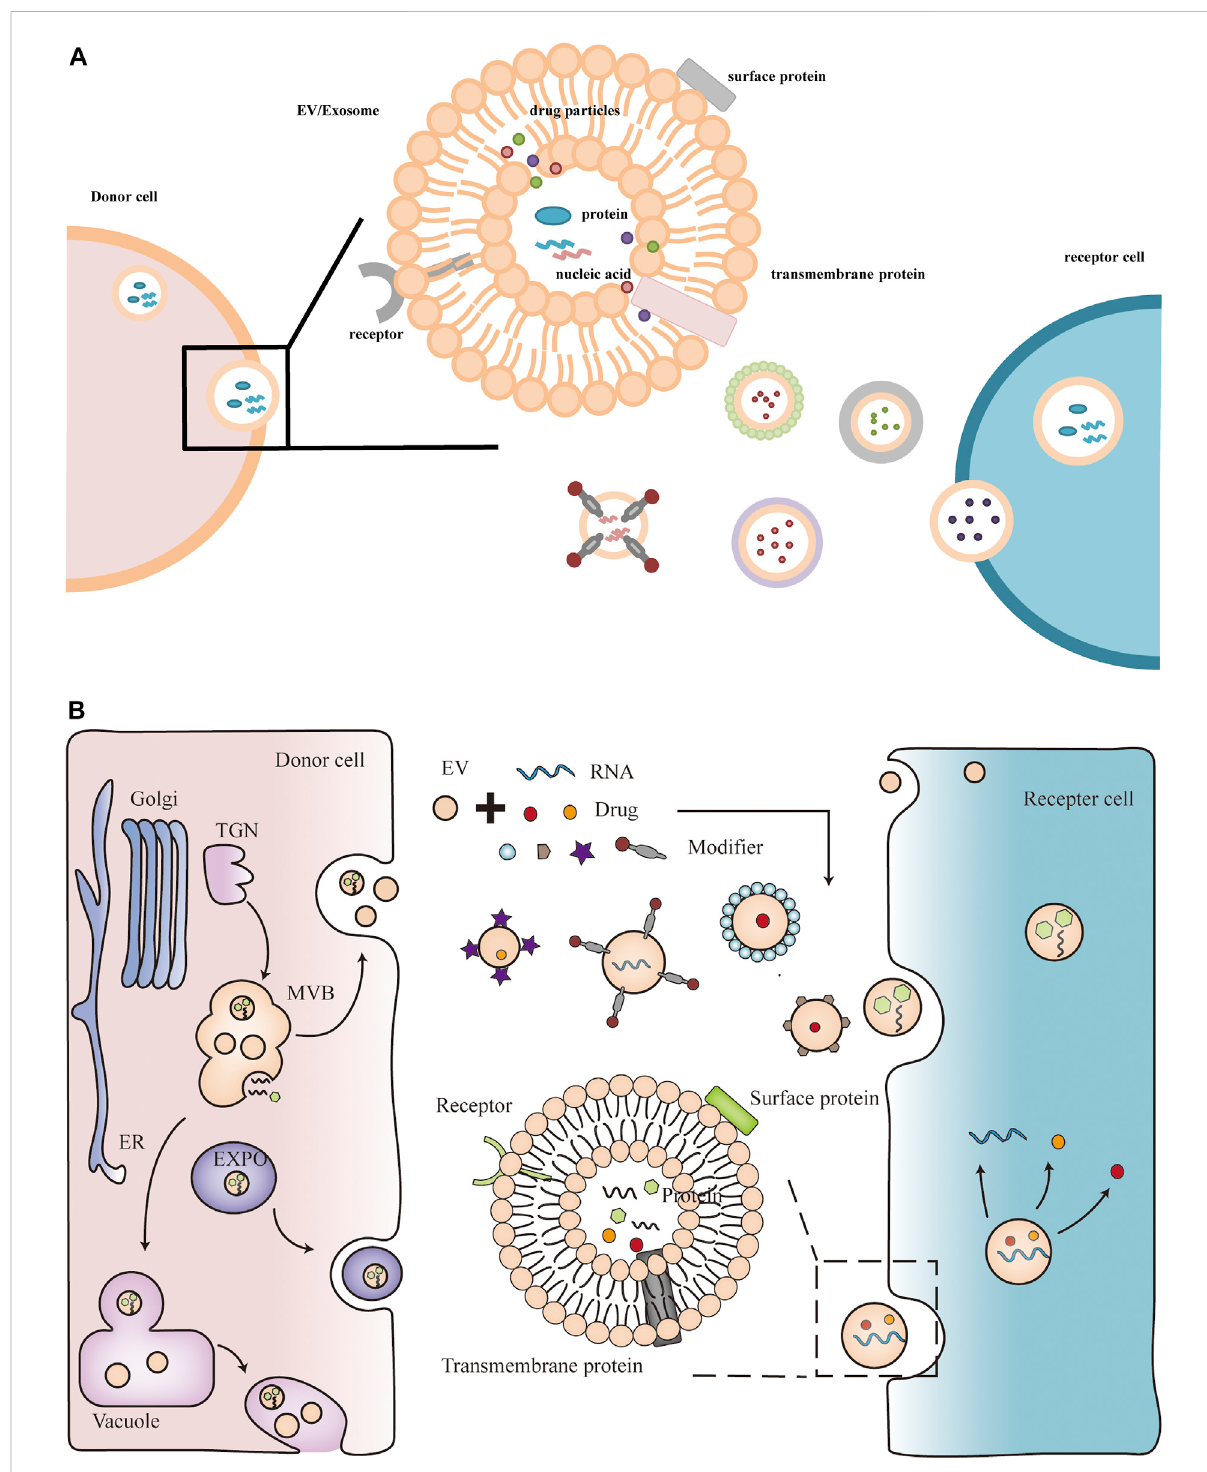
FIGURE 1 Plant extracellular vesicles contain active components such as nucleic acids and proteins. Plant extracellular vesicles can also be modi fi ed as delivery vehicles for therapeutics such as miRNAs and